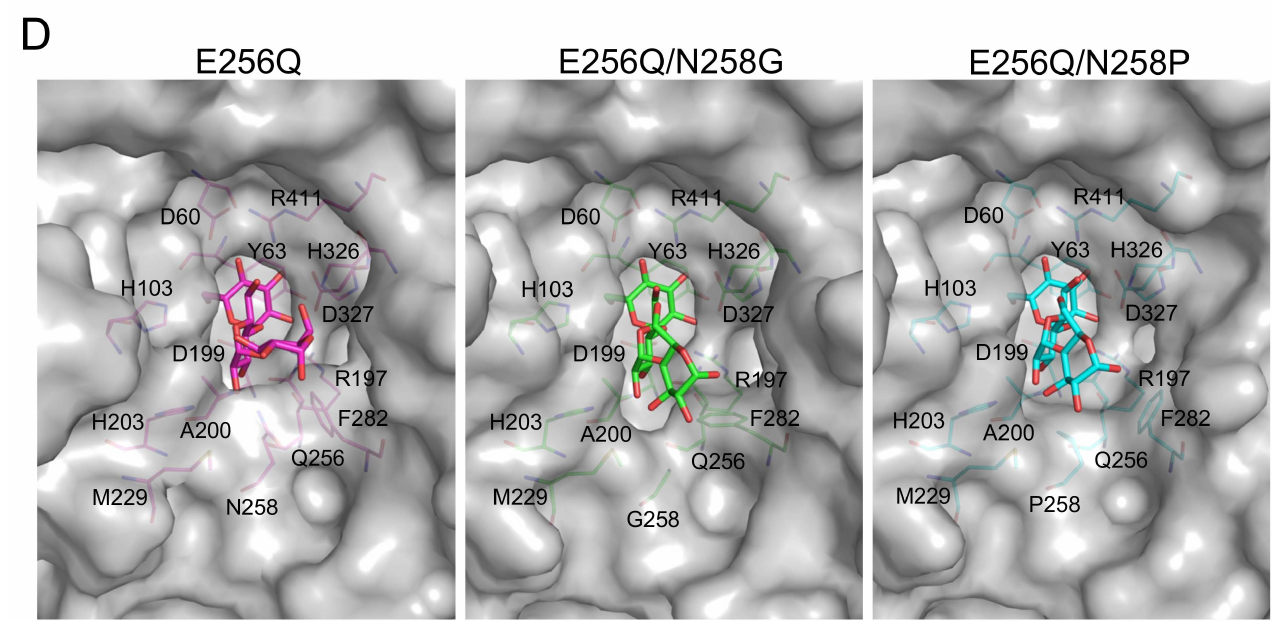
Figure 5. Structure of the active sites of E256Q/N258G and E256Q/N258P in complex with G3. The F o - F c OMIT maps of E256Q/N258G ( A ) and E256Q/N258P ( B ) (contoured at 2.5 σ ) are shown in stereo view. Red balls represent water molecules bound to the ligands. Ligands are shown as yellow sticks. Putative hydrogen bonds are indicated by yellow dotted lines. The subsite numbers are shown. The superimposition of E256Q, E256Q/N258G, and E256Q/N258P is shown in panel ( C ). E256Q (PDB entry, 5ZCD), E256Q/N258G, and E256Q/N258P are shown in magenta, green, and cyan stick representations, respectively. Surface models of the BspAG13_31A variants are shown in panel ( D